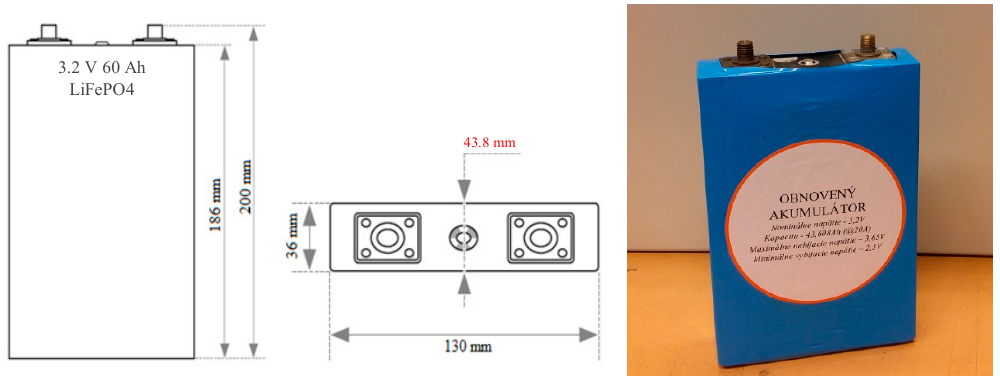
Figure 7. Evaluation of geometrical changes valid for center points of the width of deeply discharged cell ( left ) and a physical sample of this cell ( right ).